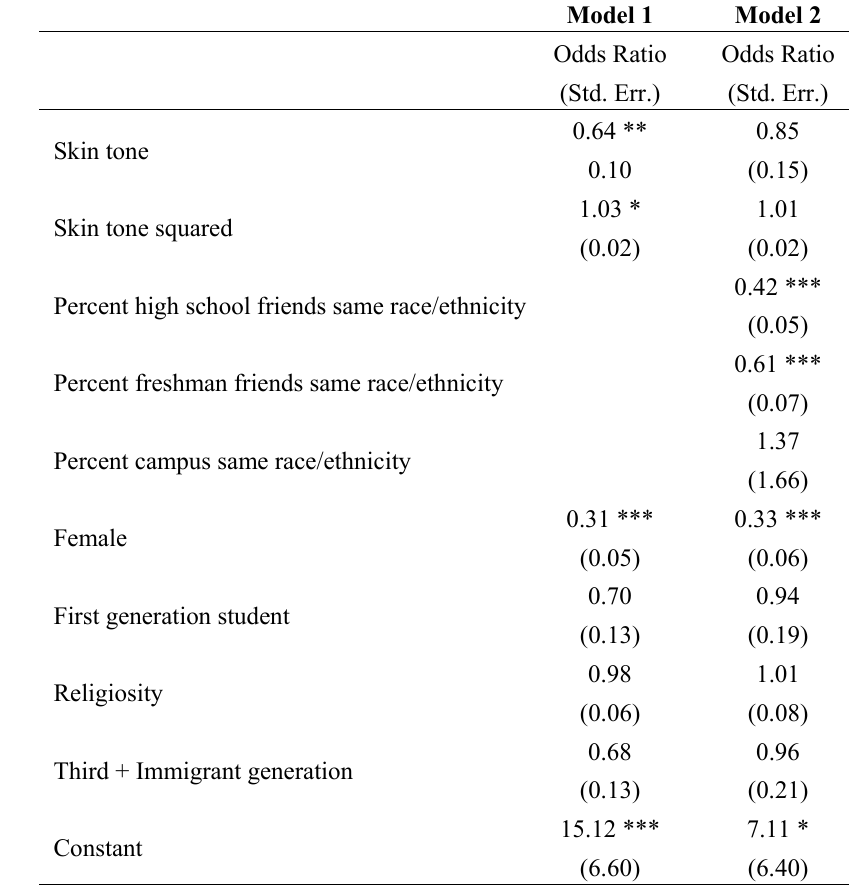
Figure 1. Association between skin tone and likelihood of intercultural dating.